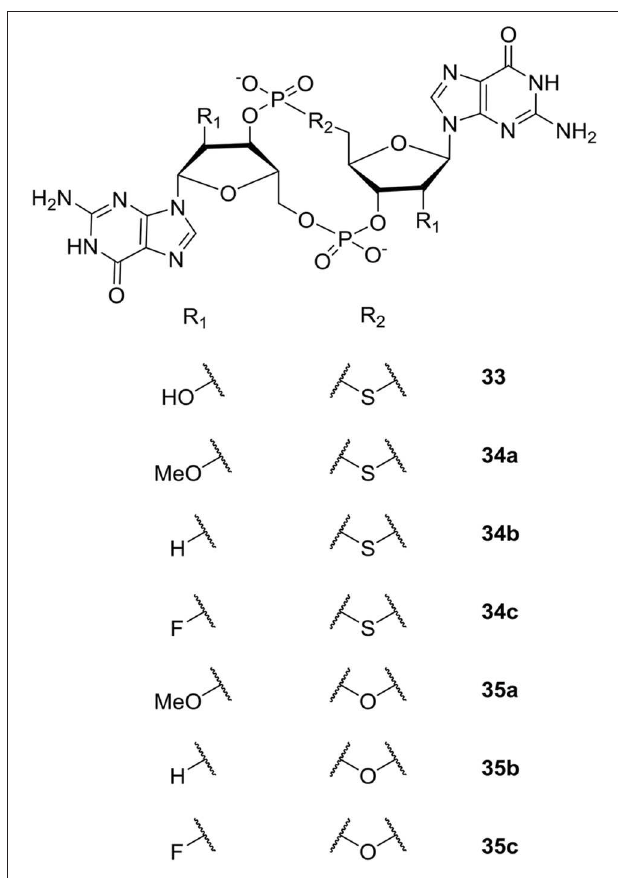
FIGURE 8 | C-di-GMP analogs studied by the group of Sintim (Wang et al., 2011; Zhou et al., 2012, 2013 ).